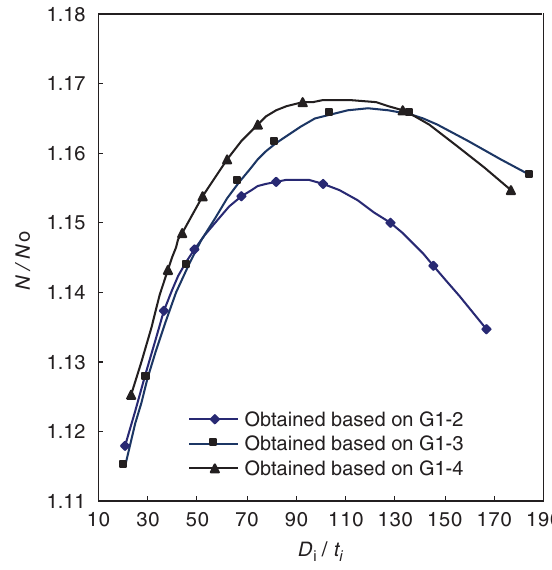
Fig. 7. Predicted axial load ( N / N 0 ) versus D i / t i interaction